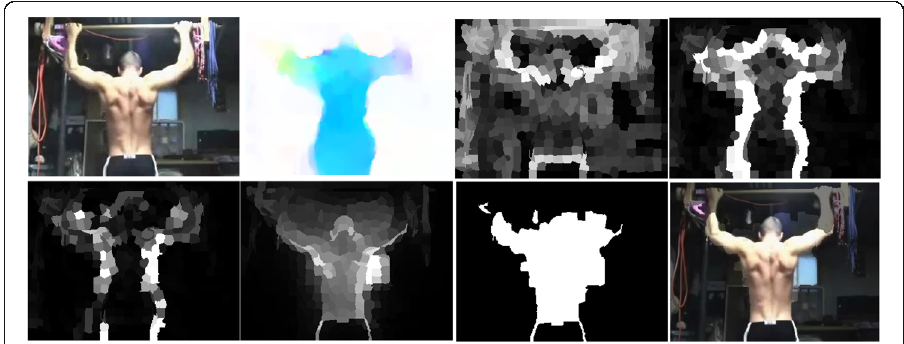
Fig. 3 Visualization of the saliency-aware motion enhancement intermediate procedures. From left to right in the first row: source video frame, optical flow, static edge map, and motion edge map. From left to right in the second row: spatio-temporal edge map, saliency map, foreground motion mask, and enhanced video